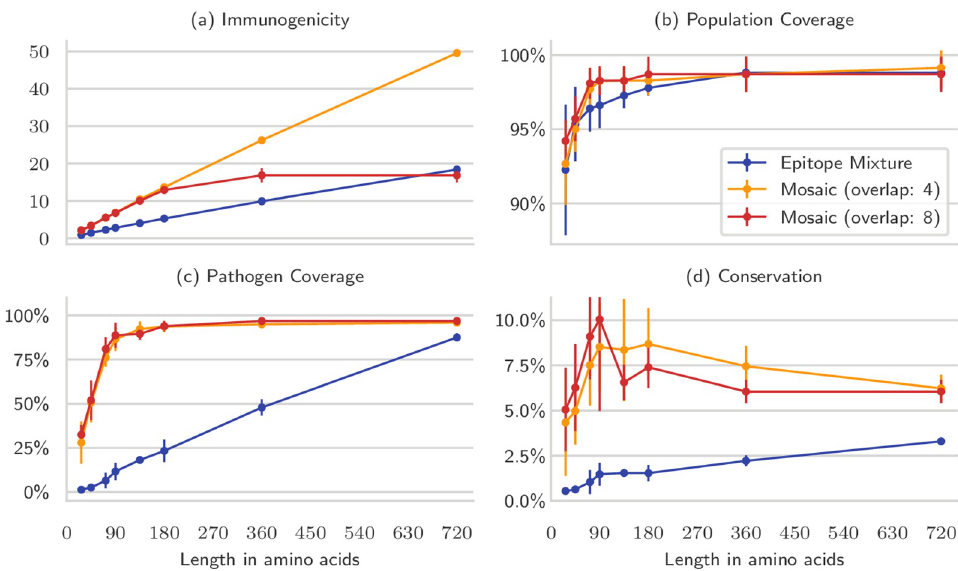
Fig 6. Comparison of mosaic and epitope mixture vaccines of different sizes. Mosaic vaccines were much better than epitope mixtures or string-of-beads of the same length (blue), as long as the pathogens offer enough epitope variety. By enforcing an overlap between epitopes of eight amino acids (red), the vaccine did not improve after a certain length. This could be prevented by relaxing this requirement to only four amino acids (yellow). The vaccines are compared with respect to four metrics: immunogenicity (a), population coverage (b), pathogen coverage (c), and conservation (d). The experiment was repeated for each of the five bootstraps, and bars represent the resulting standard deviation. Note that these vaccines were not designed with pathogen coverage nor epitope conservation in mind; mosaics naturally reached higher